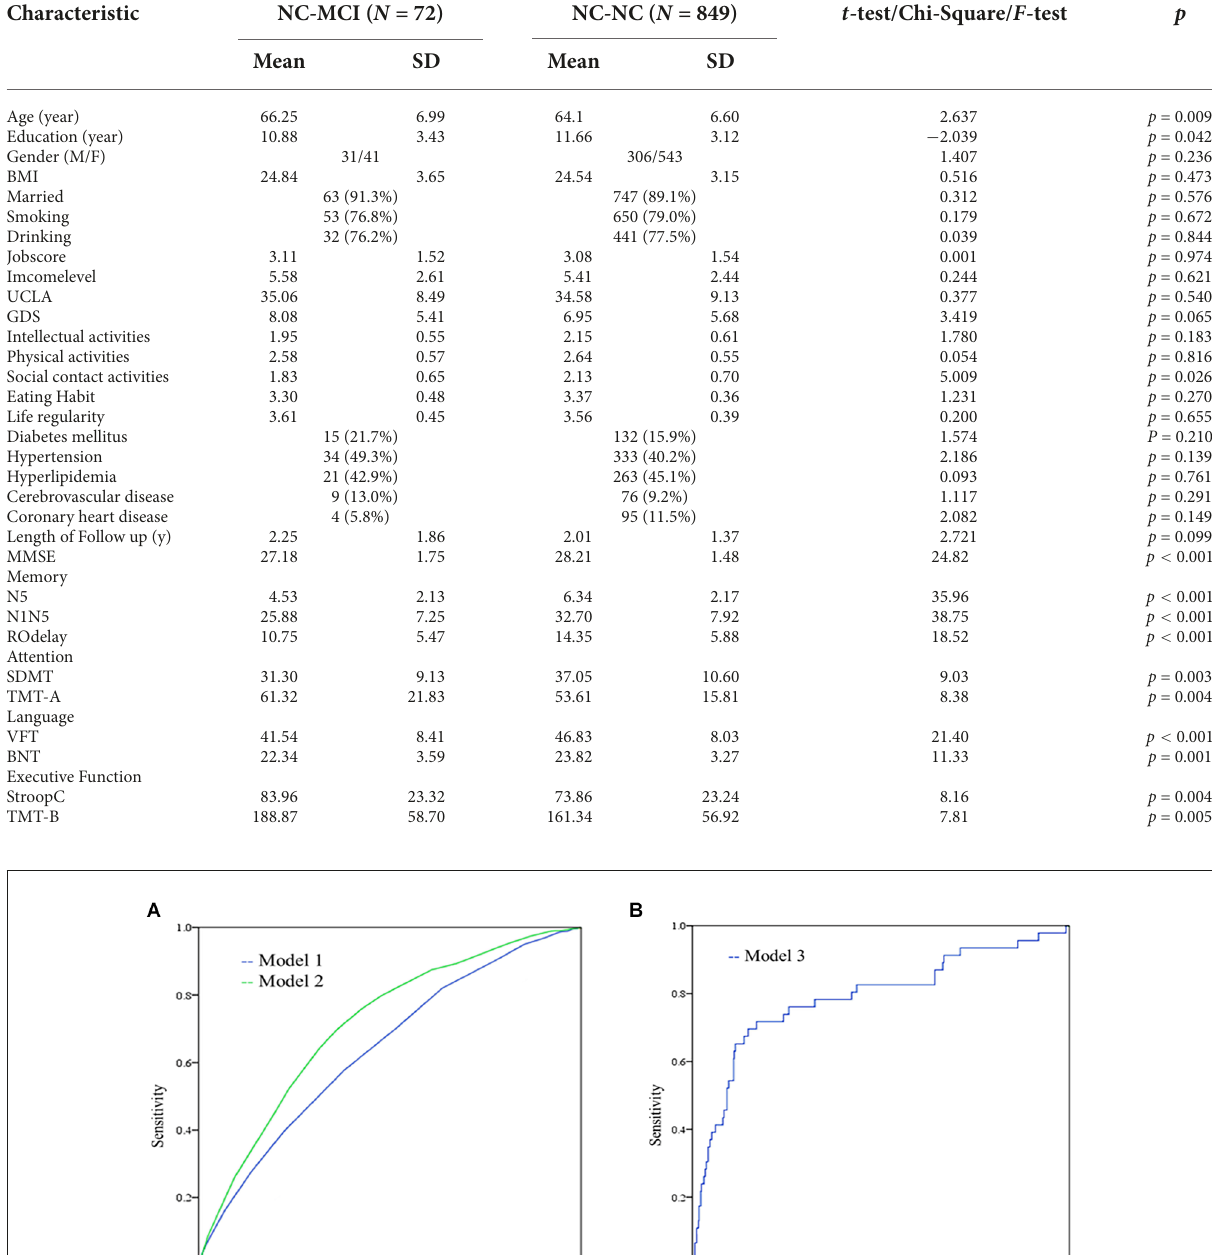
TABLE 4 Characteristics of the study sample at baseline by incident MCI status.